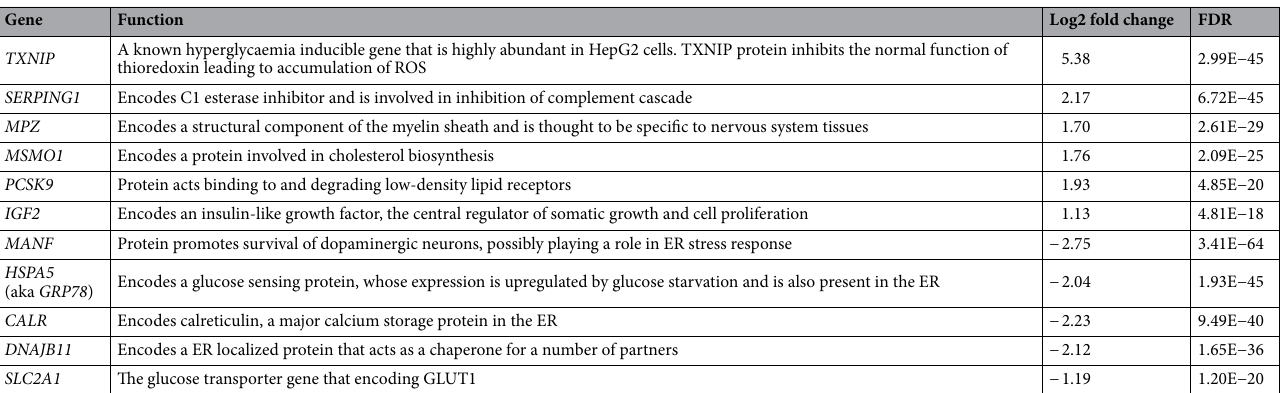
Table 1. Selected genes differently regulated by hyperglycaemia exposure in HepG2 cells. FDR, false discovery